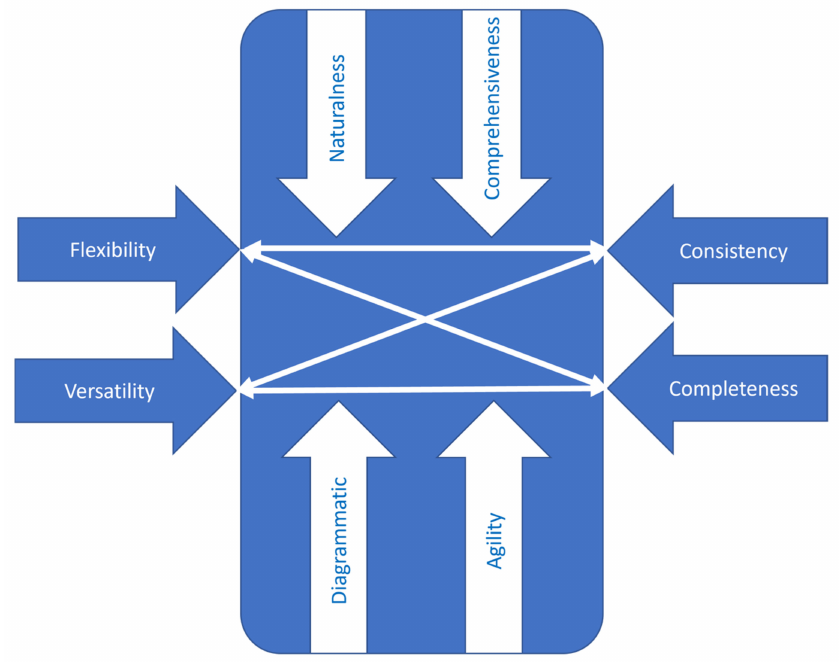
Figure 1. Framework for designing the new